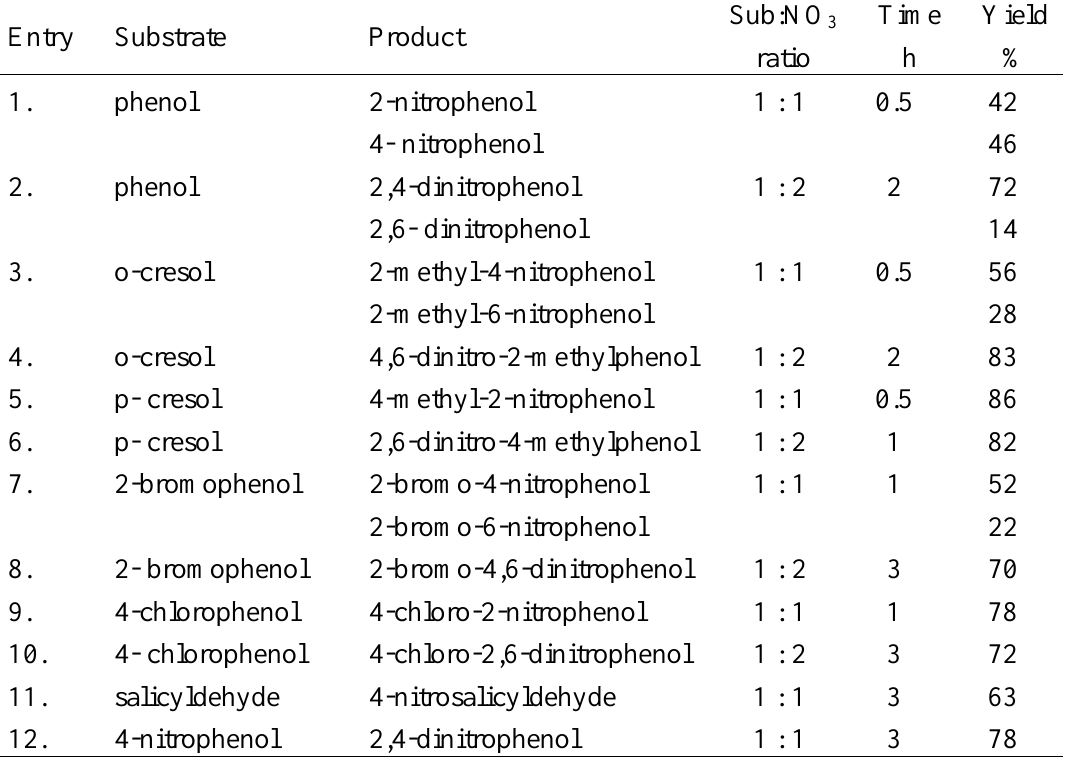
Table 3. Nitration of Phenols with Bismuth